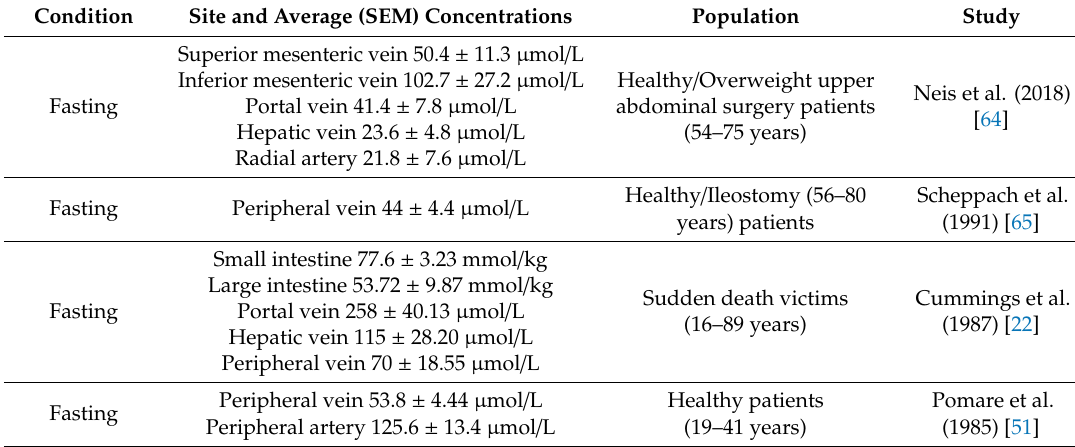
Table 1. Circulating acetate in